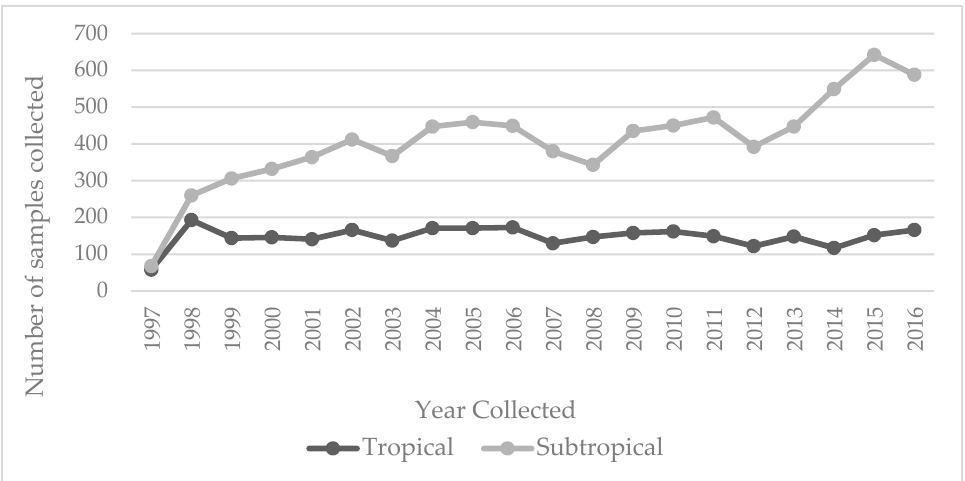
Figure 2. Total number of non-typhoid Salmonella (NTS) positive specimens per region per year collected.